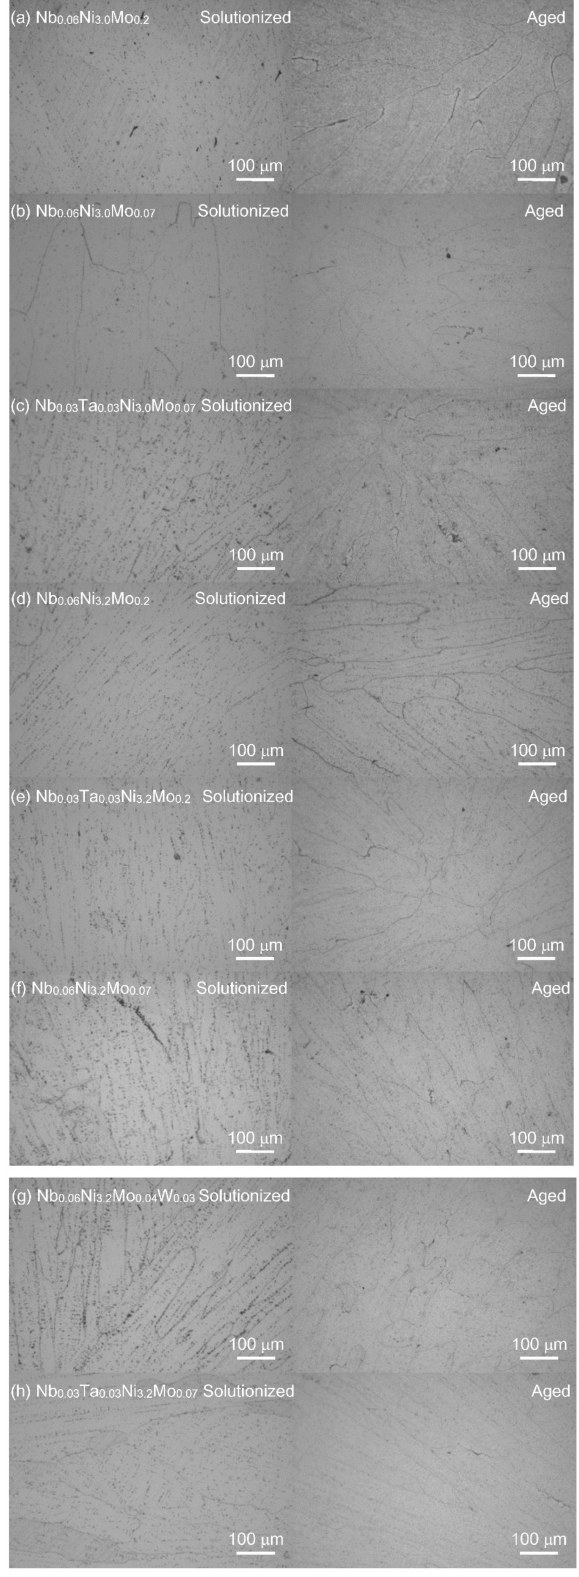
Figure 3. The optical microstructures of series-2 alloys after being solutionized at 1250 ◦ C for 1.5 h (left) and aged at 800 ◦ C for 24 h (right). ( a ): Nb 0.06 Ni 3.0 Mo 0.2 , ( b ): Nb 0.06 Ni 3.0 Mo 0.07 , ( c ): Nb 0.03 Ta 0.03 Ni 3.0 Mo 0.07 , ( d ): Nb 0.06 Ni 3.2 Mo 0.2 , ( e ): Nb 0.03 Ta 0.03 Ni 3.2 Mo 0.2 , ( f ): Nb 0.06 Ni 3.2 Mo 0.07 , ( g ): Nb 0.06 Ni 3.2 Mo 0.04 W 0.03 , ( h ): Nb 0.03 Ta 0.03 Ni 3.2 Mo 0.07